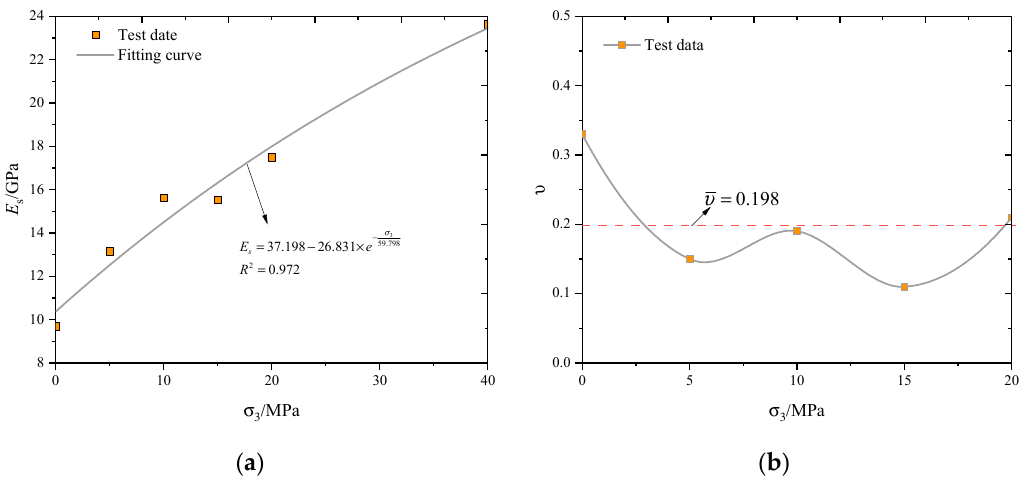
Figure 6. Influence of confining pressure on ( a ) Young’s modulus and ( b ) Poisson’s ratio of sandstone.